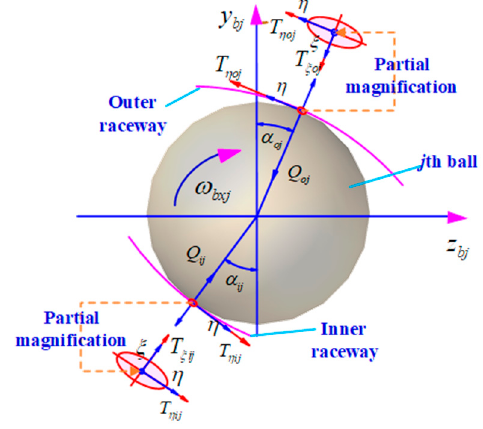
Figure 7. Forces between the j th ball and the raceways. Q Q are the normal contact forces between the j th ball and the raceways; Where , ij oj , ξ are the frictional forces along the long axis and short axis of the contact zone between the j th ball and the raceways; D is the outer diameter of the cage; and c D is the diameter of the cage pocket. p